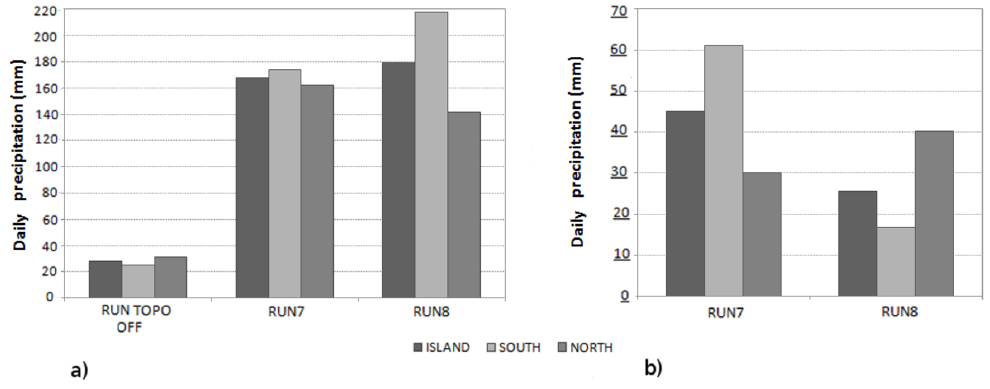
Fig. 6. (a) Daily precipitation, averaged over the whole Madeira Island and its southern and northern coasts, for domain D3, and (b) daily precipitation averaged for locations at altitudes lower than 800m, for domain Fig. 6. a) Daily precipitation, averaged over the whole Madeira Island, and its Southern and Northern coasts,